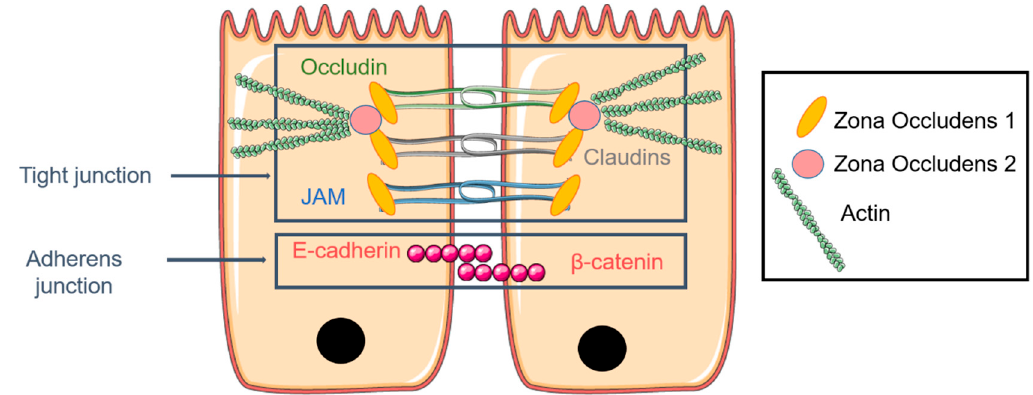
Figure 3. The pulmonary epithelium is maintained by adherent junctions and the tight junction (TJ) complex composed of occludin, claudins, and junction adhesion molecules (JAM). Zona occludens (ZO) is directly attached to actin and connects the TJ to the cytoskeleton, notably actin F.